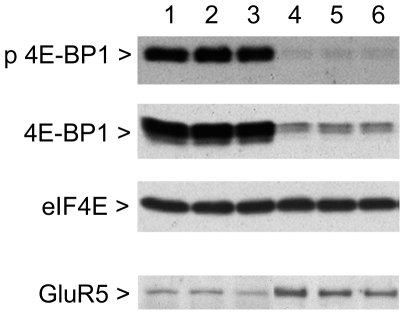
Protein expression and phosphorylation of the putative LRRK2 substrate 4E binding protein 1 (4E-BP1).Both signals decline in LRRK2+/− ES cell-derived neurons (lane 4–6) compared to wildtype cultures (lane 1–3). Protein levels of eukaryotic translation initiation factor 4E (eIF4E), the interaction partner of 4E-BP1, are unchanged. Protein expression of the ionotropic glutamate receptor 5 (GluR5) is increased in LRRK2+/− neurons (lane 4–6) compared to wildtype cells (lane 1–3). Three replicate cultures per genotype were analysed. For densitometric quantification see Results section.